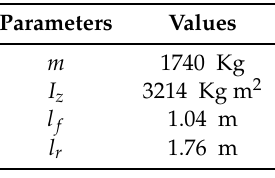
Table 2. The values of the vehicle